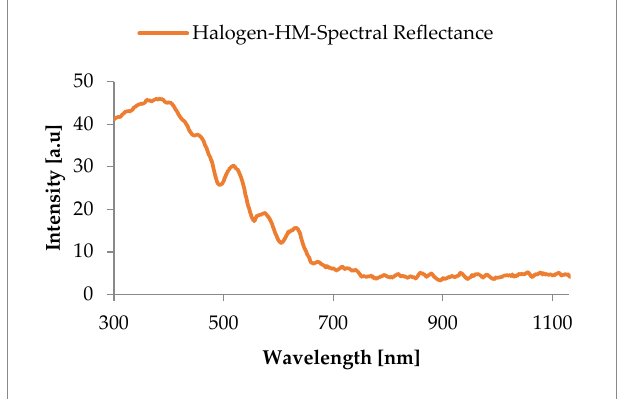
Figure 5. The halogen light spectrum reflected by hot mirror.